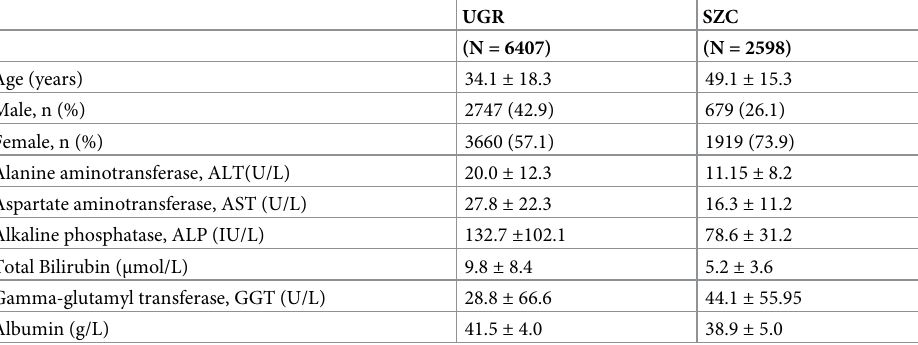
Table 1. Descriptive characteristics for the study